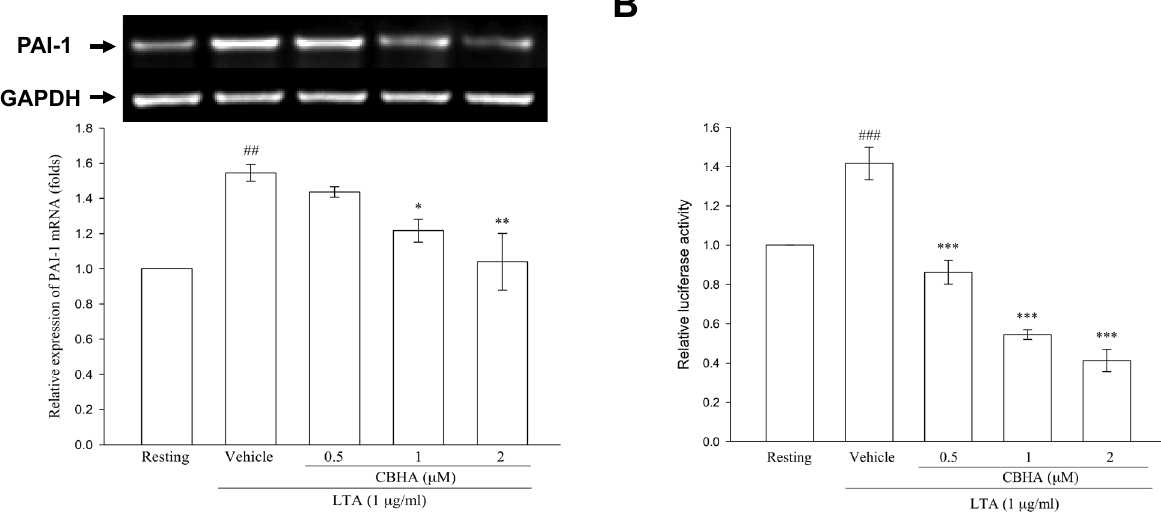
Figure 3. CBHA blocks LTA-induced JNK phosphorylation in human PMCs. ( A ) MeT-5A cells were treated with vehicle or various signal pathway inhibitors inclusive of parthenolide (Par, 10 μ M), LY294002 (LY, 20 μ M), PD98059 (PD, 20 μ M), SB203580 (SB, 10 μ M) and SP600125 (SP, 10 μ M), respectively, then stimulated with LTA for 24 h. PAI-1 expression was analyzed by western blot and measured by optical densitometry analysis. Data were pooled from three independent experiments and expressed as average fold change (mean ± SEM) in the expression relative to resting or vehicle group. ( B ) MeT-5A cells pretreated with vehicle or SP600125 (SP, 5 ‒ 10 μ M) were stimulated with LTA for 24 h. Collagen I expression was analyzed by western blot and measured by optical densitometry analysis. Data were pooled from three independent experiments and expressed as average fold change (mean ± SEM) in the expression relative to resting or vehicle group. ( C ) MeT-5A cells were treated with LTA for the indicated times, and JNK phosphorylation was evaluated. ( D ) MeT-5A cells were treated with LTA, with or without CBHA pretreatment (0.5, 1 or 2 μ M), and the expression levels of phosphorylated or total JNK were examined in cell lysates by western blot and measured by optical densitometry analysis. Data were pooled from three independent experiments and expressed as average fold change (mean ± SEM) in the expression relative to resting or vehicle group. ( E ) MeT-5A cells transfected with control siRNA or JNK3 siRNA were stimulated by LTA for 24 h with or without CBHA pretreatment (1 μ M), and the expression of PAI-1 and total JNK were examined by western blot. ### p <0.001 compared with the resting group; * p < 0.05, ** p < 0.01, *** p < 0.001 compared with